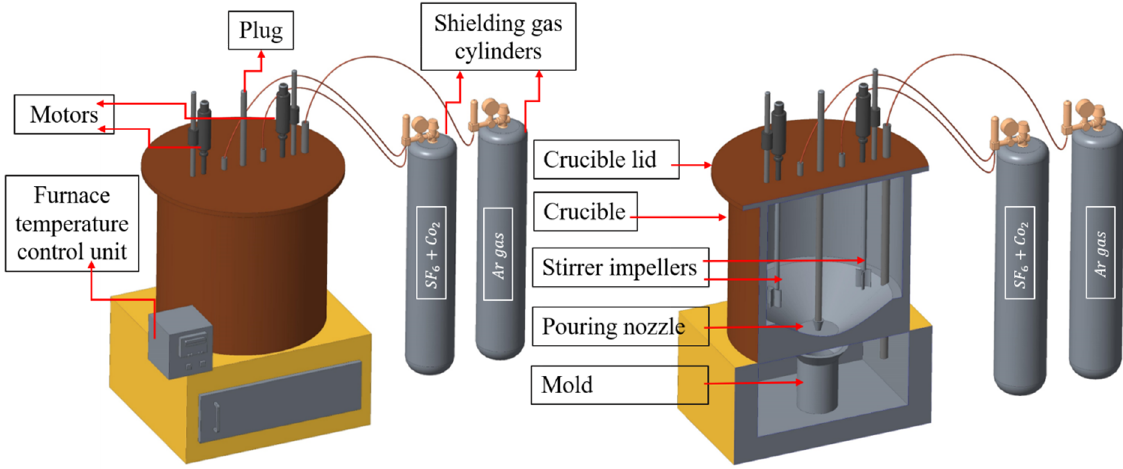
Figure 1. Gravitational melt-stir casting setup and main